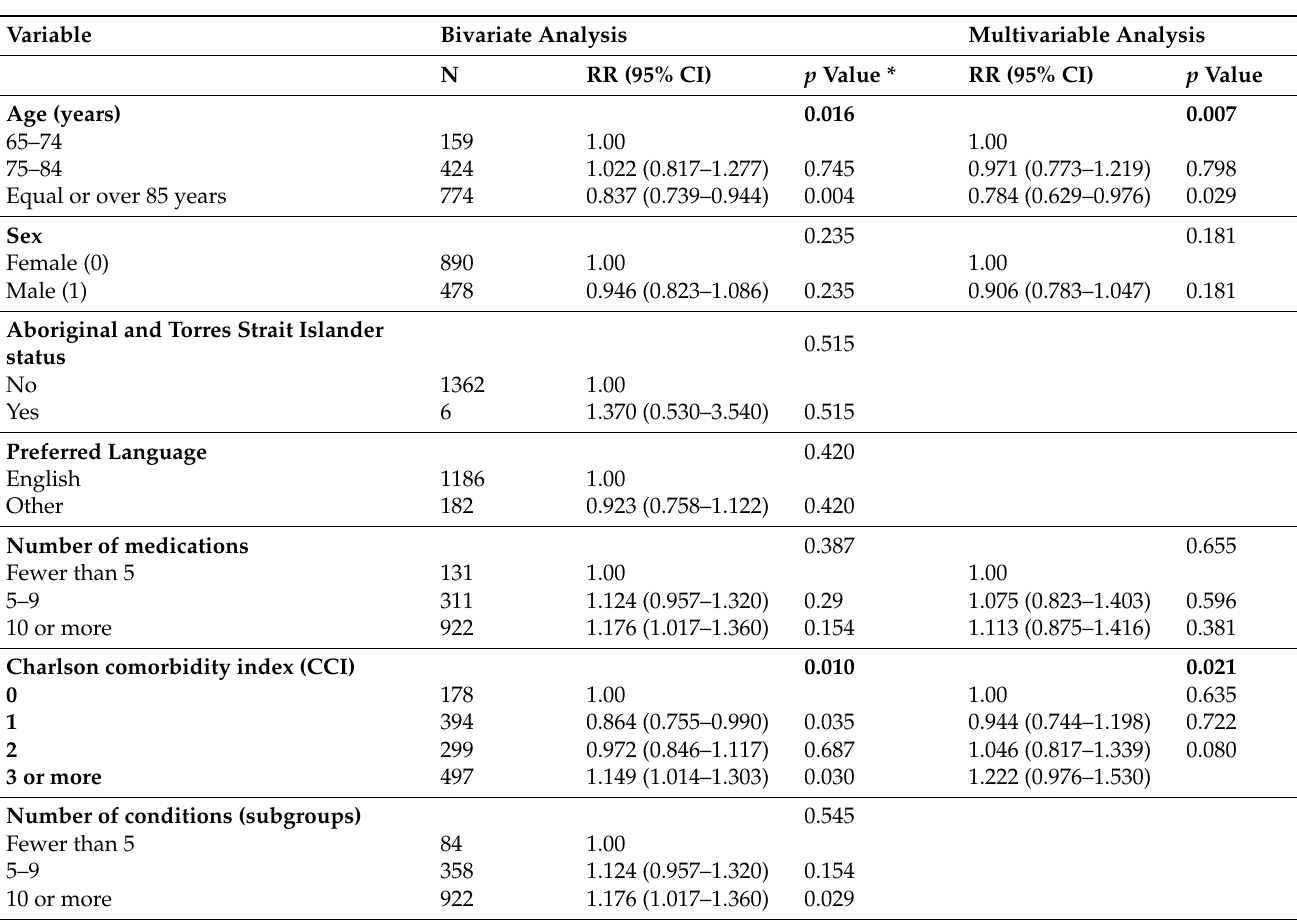
Table 4. Factors associated with potential inappropriate medications in bivariate and Multivariable